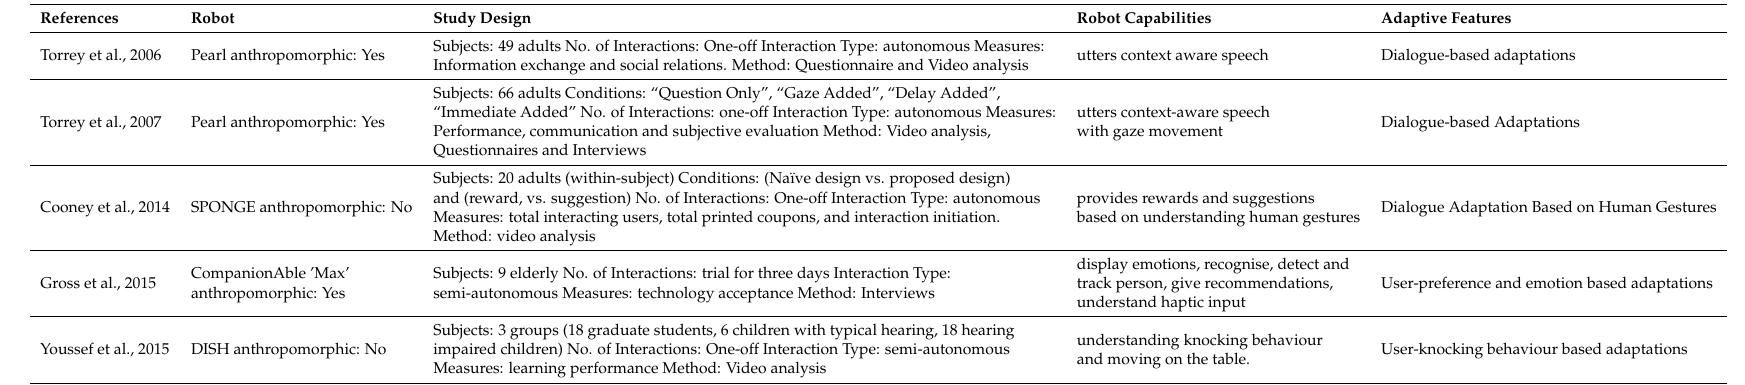
Table 4. Summary of Adaptive Interaction studies in